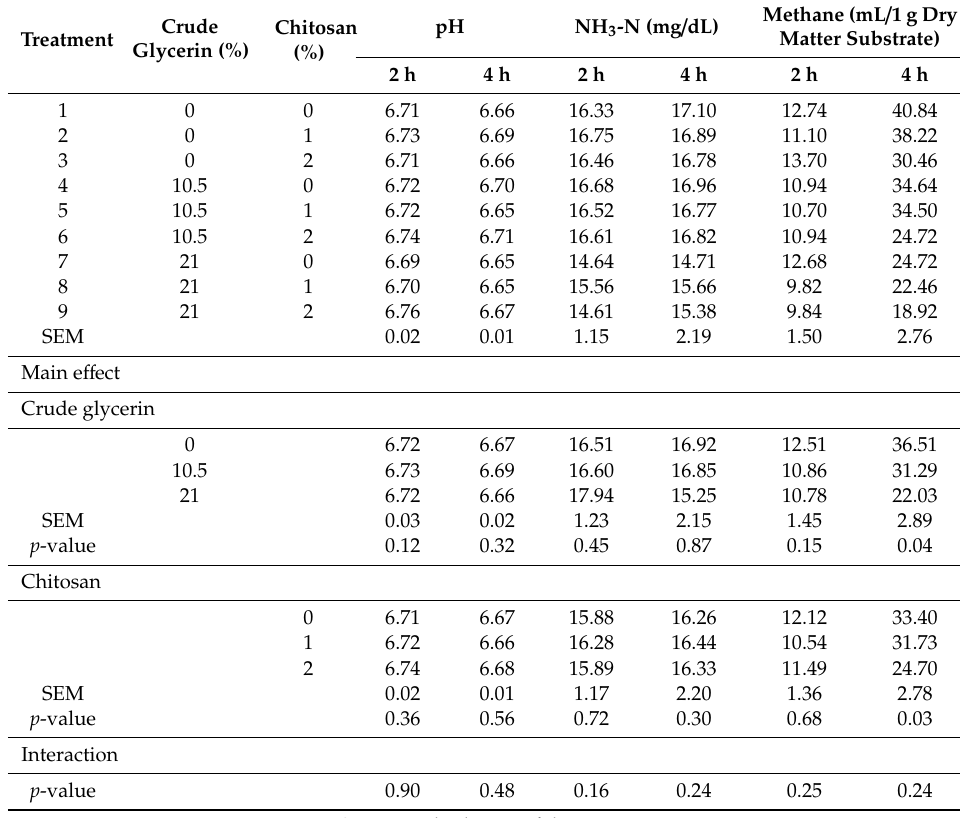
Table 3. Influence of crude glycerin with chitosan on pH, ammonia-nitrogen (NH 3 -N) content and methane production using in vitro gas production technique after 2 and 4 h of